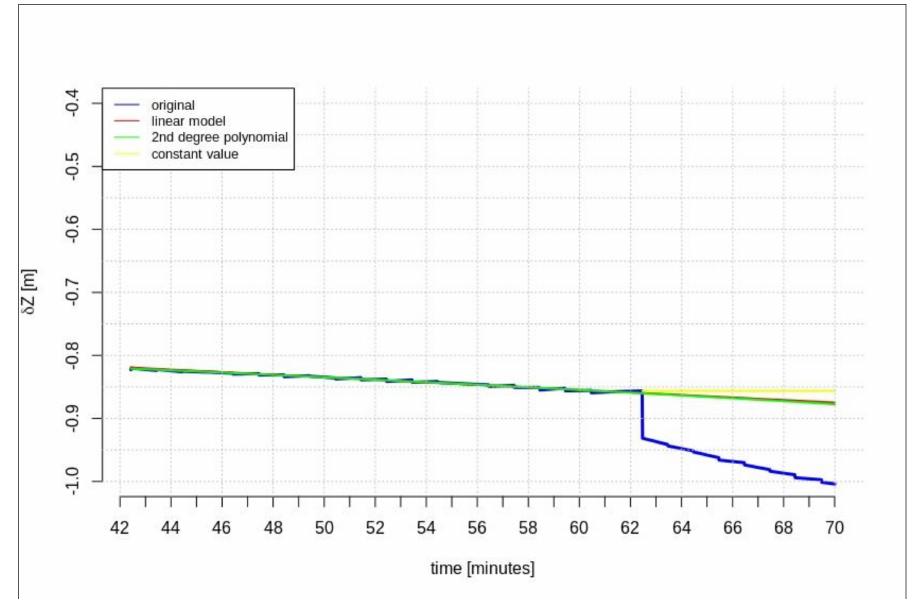
Figure 10. The results of the δ Z geocentric corrections extrapolation (GPS G13) for a 15 min data-stream—the time series of the orbit corrections refer to an out-of-date navigation